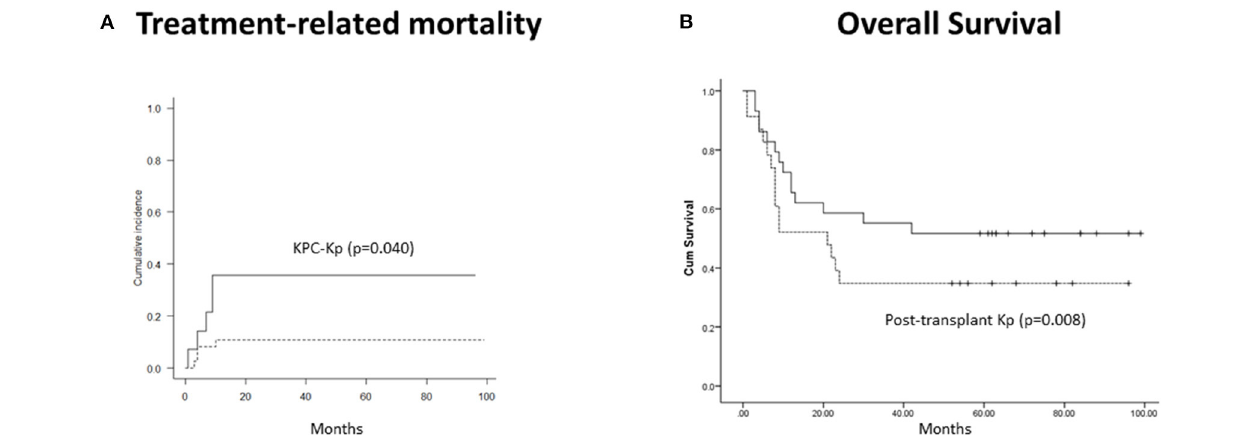
FIGURE 1 | Outcomes in patients with Kp isolates before alloHCT ( n = 52). (A) Treatment-related mortality was significantly higher in patients with KPC-Kp detection ( p = 0.040). (B) Overall survival was significantly lower in patients with post-transplant Kp detection ( p = 0.008). KP, Klebsiella pneumoniae ; KPC, Klebsiella